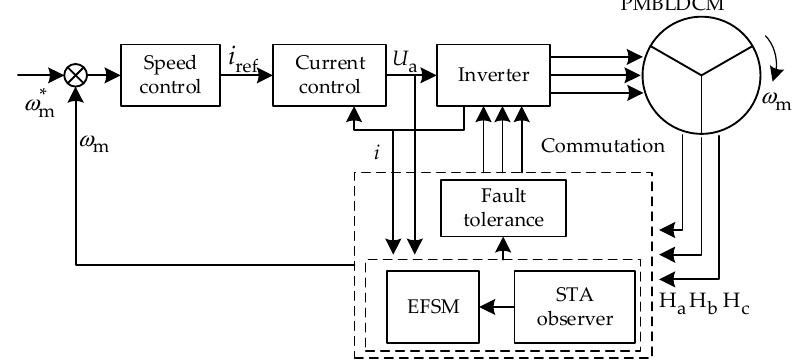
Figure 10. The overall structure of the control system.